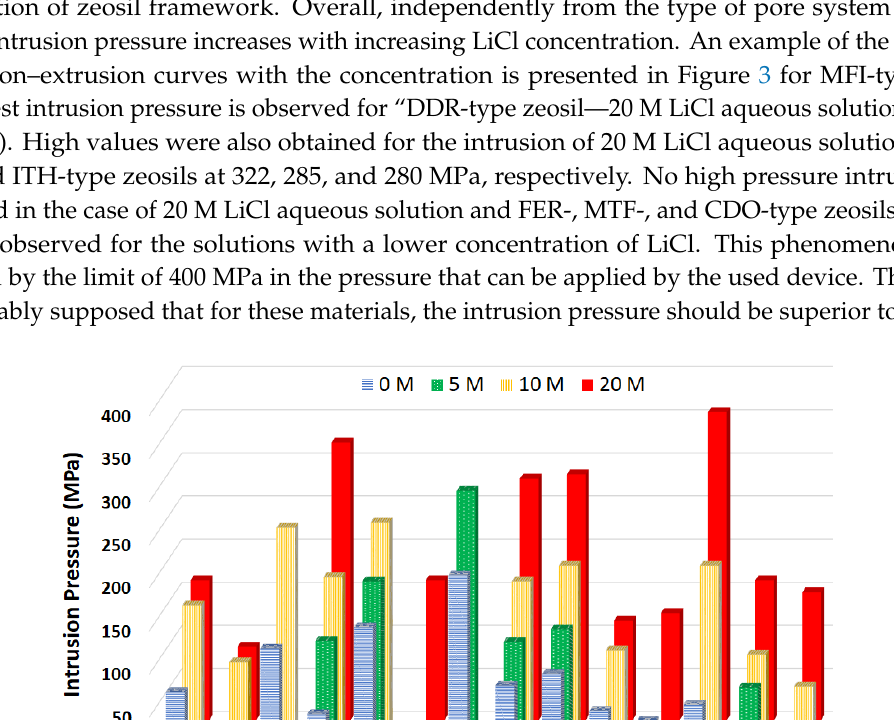
Figure 2. Intrusion pressure values of different “zeosil–LiCl aqueous solution” systems in function of solution concentration of 0 (water), 5, 10, and 20 M.